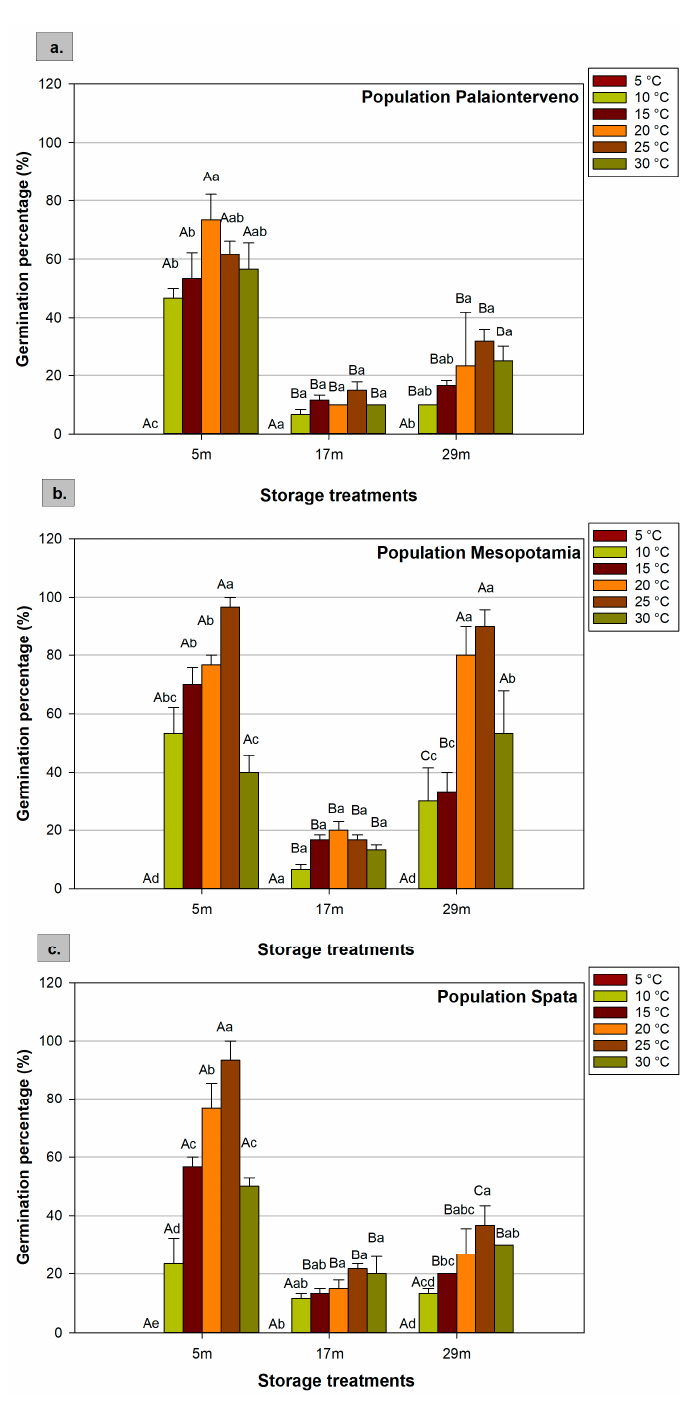
Figure 1. Effect of population (( a ) Palaionterveno, ( b ) Mesopotamia, and ( c ) Spata), storage (duration and conditions: 5, 17, and 29 refer to the months (m) of storage and the conditions that prevailed during storage), and temperature (5 °C, 10 °C, 15 °C, 20 °C, 25 °C, and 30 °C) on milk thistle seeds’ germination percentage. Capital letters show significant differences between storage treatments at the same temperature, while small letters show significant differences between temperatures at the same storage treatment. The bars represent the standard error of the means.